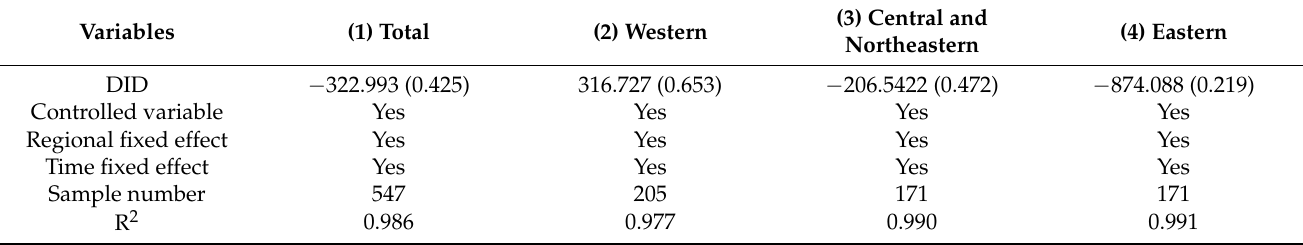
Table 3. Impacts of the coupling